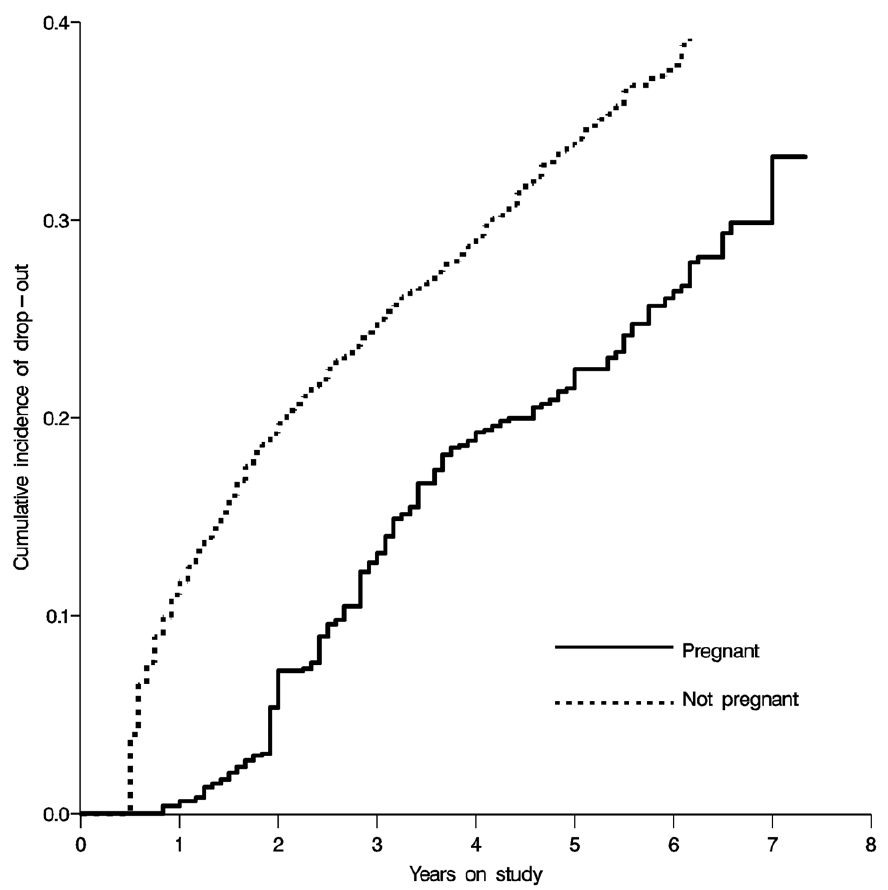
Figure 3. Effect of pregnancy on time to drop-out, displayed as weighted inverse extended Kaplan-Meier curves.